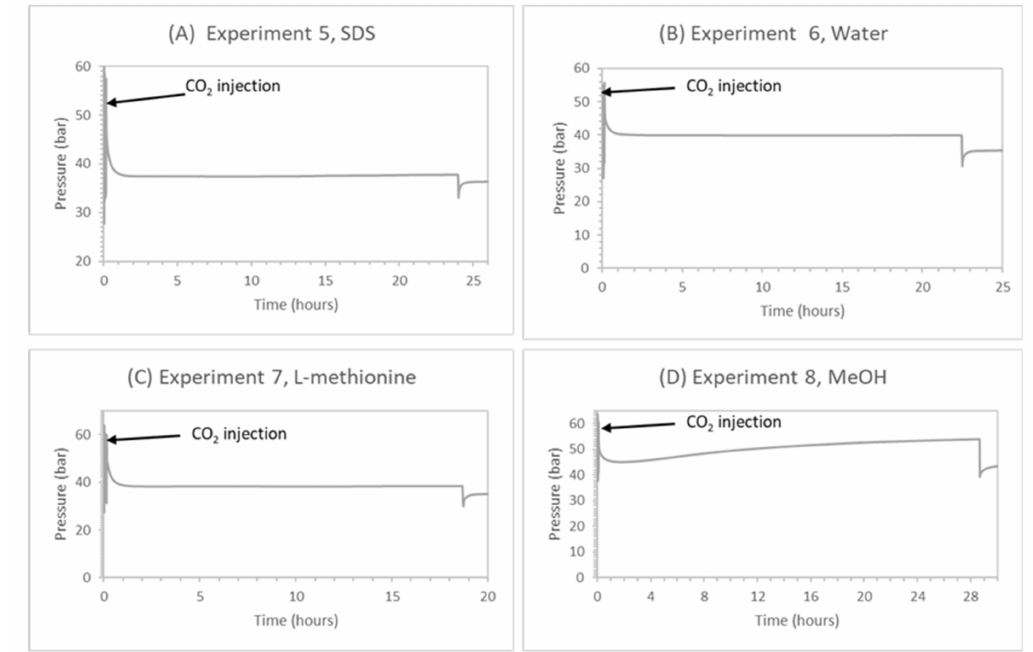
Figure 13. Pressure profiles for CH 4 -CO 2 replacement process 24 h after soaking in experiments 5–8 having similar S wi but in the presence of di ff erent additives in the water. Sudden drop in pressure at the end of 24 h corresponds to gas collection for GC analysis followed by controlled depressurization. ( A ) Pressure profile after CO 2 injection and during the soaking period in experiment 5; ( B ) Pressure profile after CO 2 injection and during the soaking period in experiment 6; ( C ) Pressure profile after CO 2 injection and during the soaking period in experiment 7; ( D ) Pressure profile after CO 2